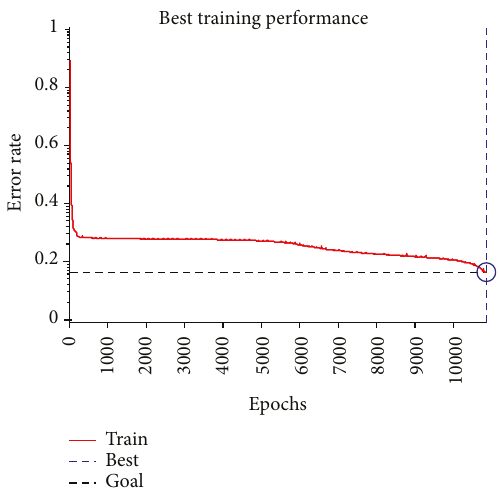
Figure 12: Network training of masonry